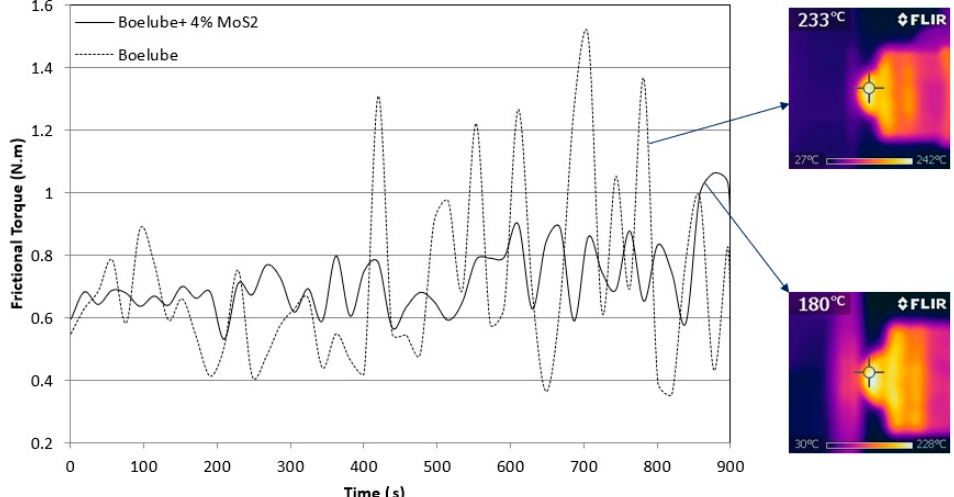
Figure 8. Frictional torque and surface temperature of the top WC ball against Ti lower balls at 3.5 GPa contact stress for Boelube and Boelube with MoS 2 nanoparticles.